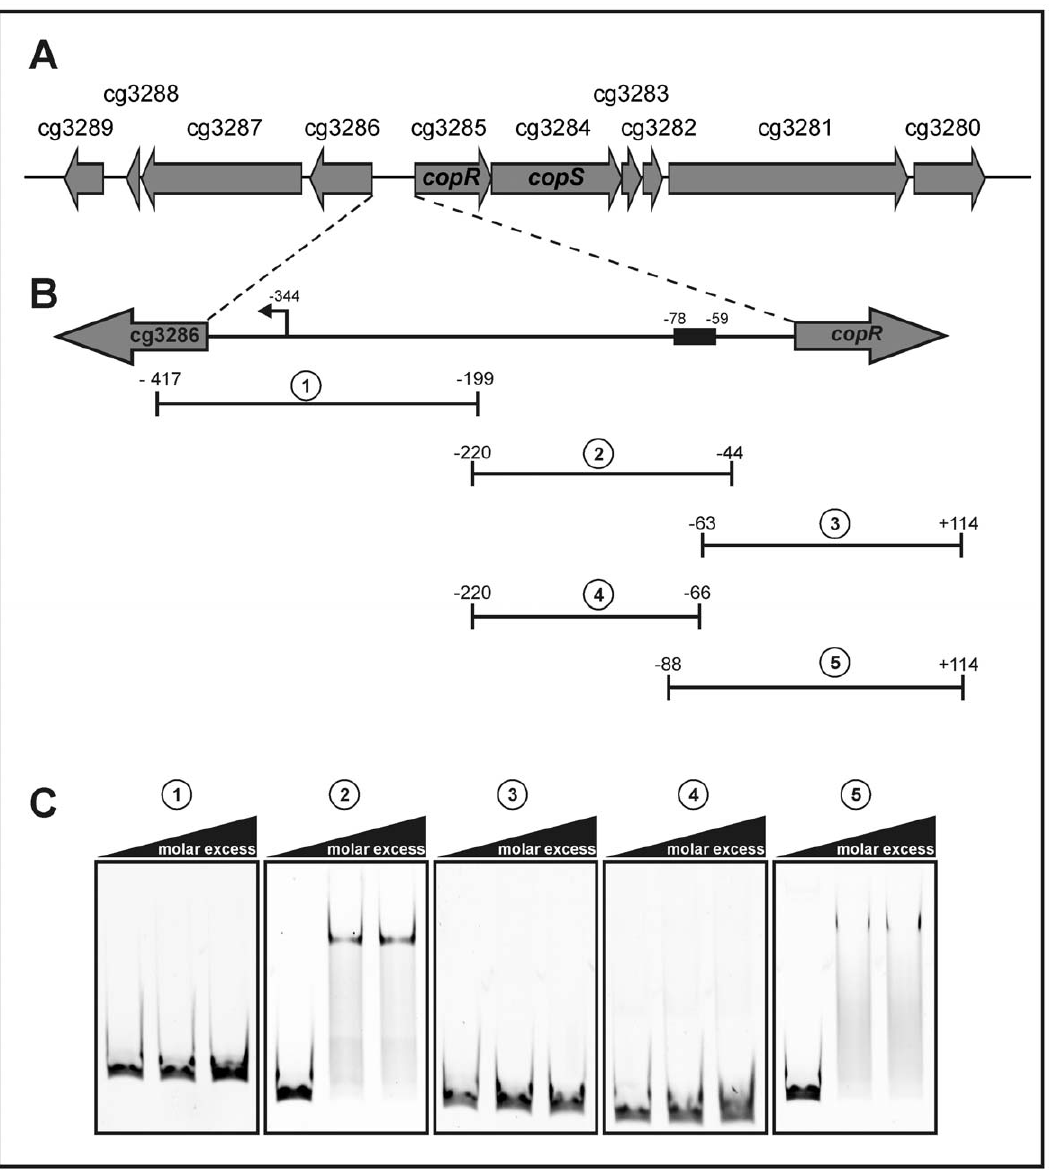
Figure 4. Search for the CopR-binding motif within the cg3286- copR intergenic region. (A) Scheme of the genome region covering cg3280-cg3289 based on the CoryneRegNet annotation (http://coryneregnet.cebitec.uni-bielefeld.de). The genes code for a secreted protein of unknown function (cg3280), a probable cation-transporting ATPase transmembrane protein ( copB , cg3281), a heavy metal binding transport protein (cg3282), a protein of unknown function (cg3283), a secreted protein of unknown function (cg3286), a secreted multicopper oxidase ( copO , cg3287), a protein of unknown function (cg3288) and a thioredoxin-like protein ( tlpA , cg3289). (B) Enlargement of the cg3286- copR intergenic region and position of DNA fragments 1-5 used for EMSAs. The numbers above the DNA fragments indicate the bp distance of their ends to the translation start site of copR . (C) EMSAs with fragments 1–5 (100 nM, 155–219 bp in length) and phosphorylated CopR. The molar excesses of the CopR used were 0-, 25-,